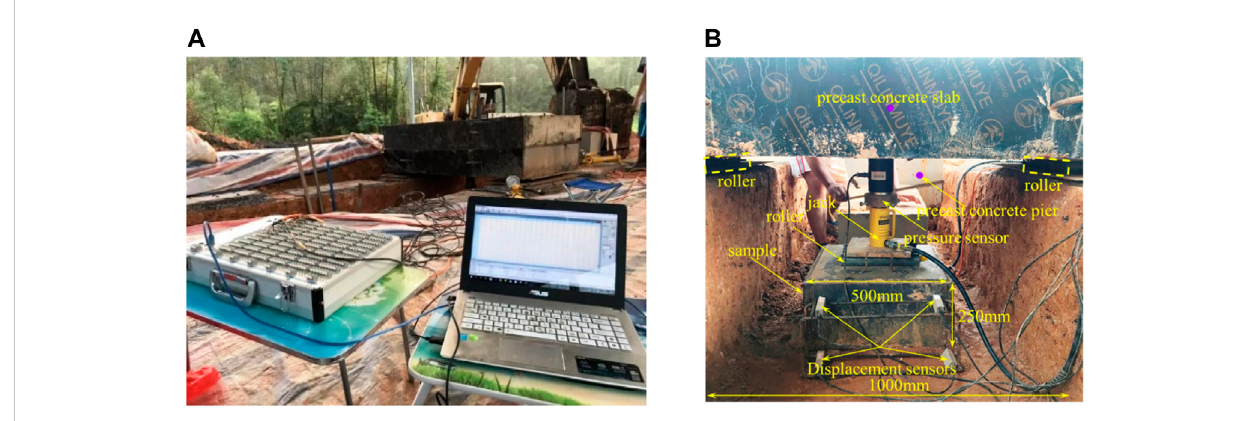
FIGURE 7 Photos of assembly of large-scale direct shear apparatus. (A) Reaction an data acquisition system, and (B) Loading of large direct shear samples.